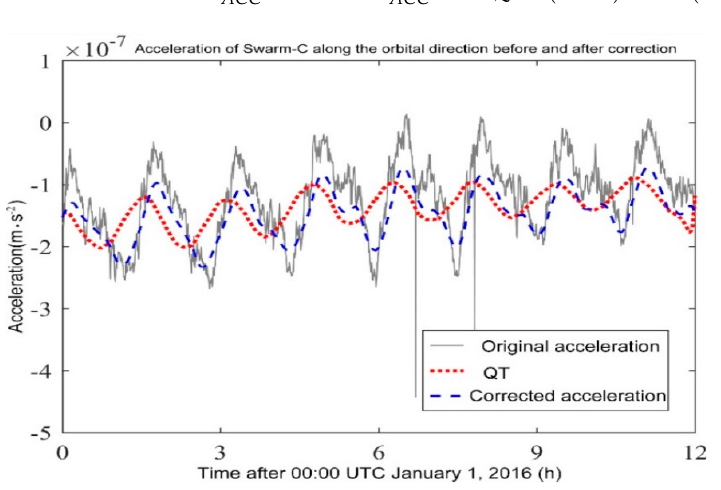
Figure 3. Comparison of Swarm-C satellite accelerometer data before and after correction.